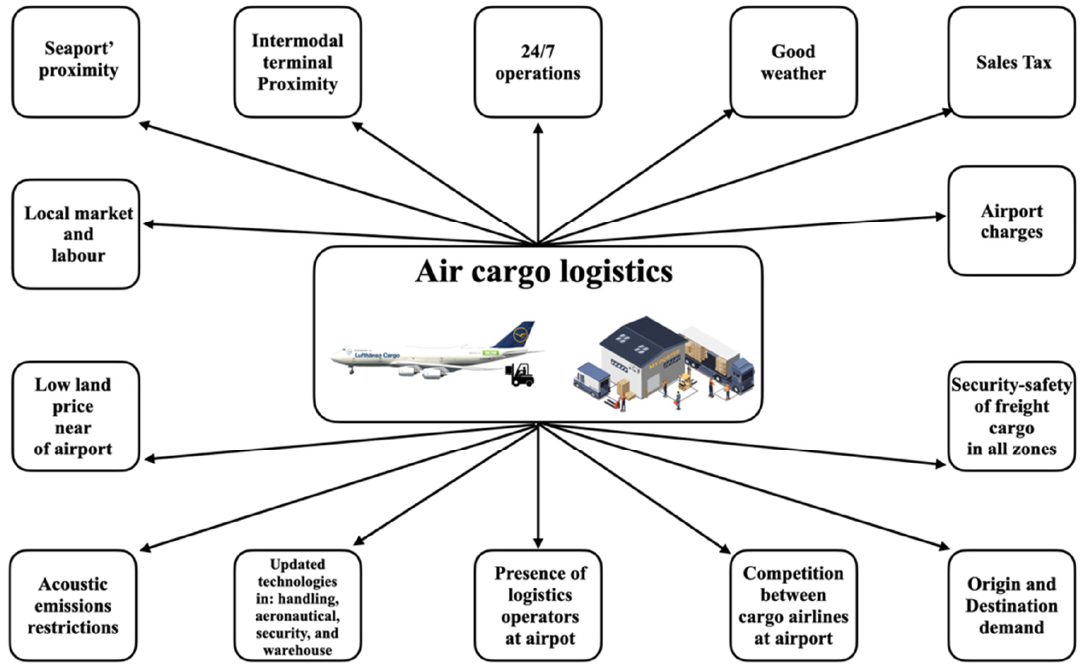
Figure 3. The main factors in the growth of air cargo logistics. Source. Own elaboration.